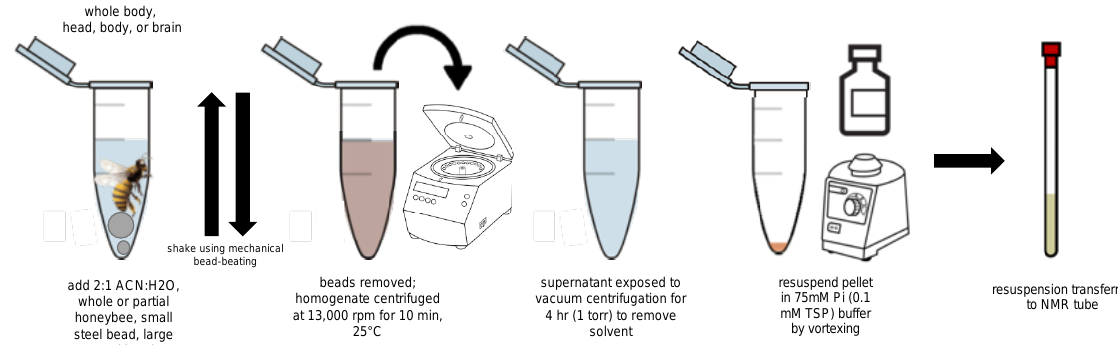
Figure 1. Organic extraction of whole bees as well as components (body, head, brain) was developed with acetonitrile:water mixtures. Prior work employed chloroform/methanol protocols, but acetonitrile achieves improved metabolite recovery and moderate reduction in sugars.